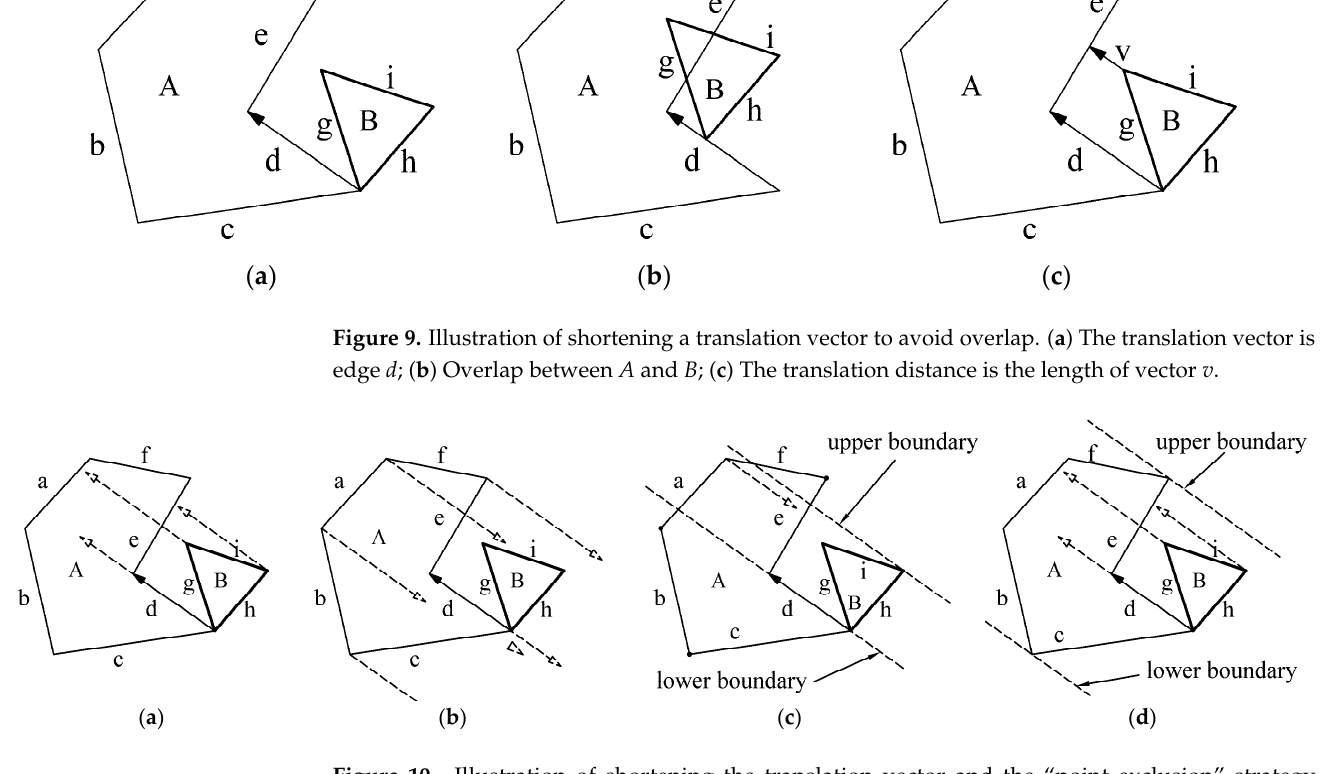
Figure 9. Illustration of shortening a translation vector to avoid overlap. ( a ) The translation vector is edge d ; ( b ) Overlap between A and B ; ( c ) The translation distance is the length of vector v . (i) Computation method